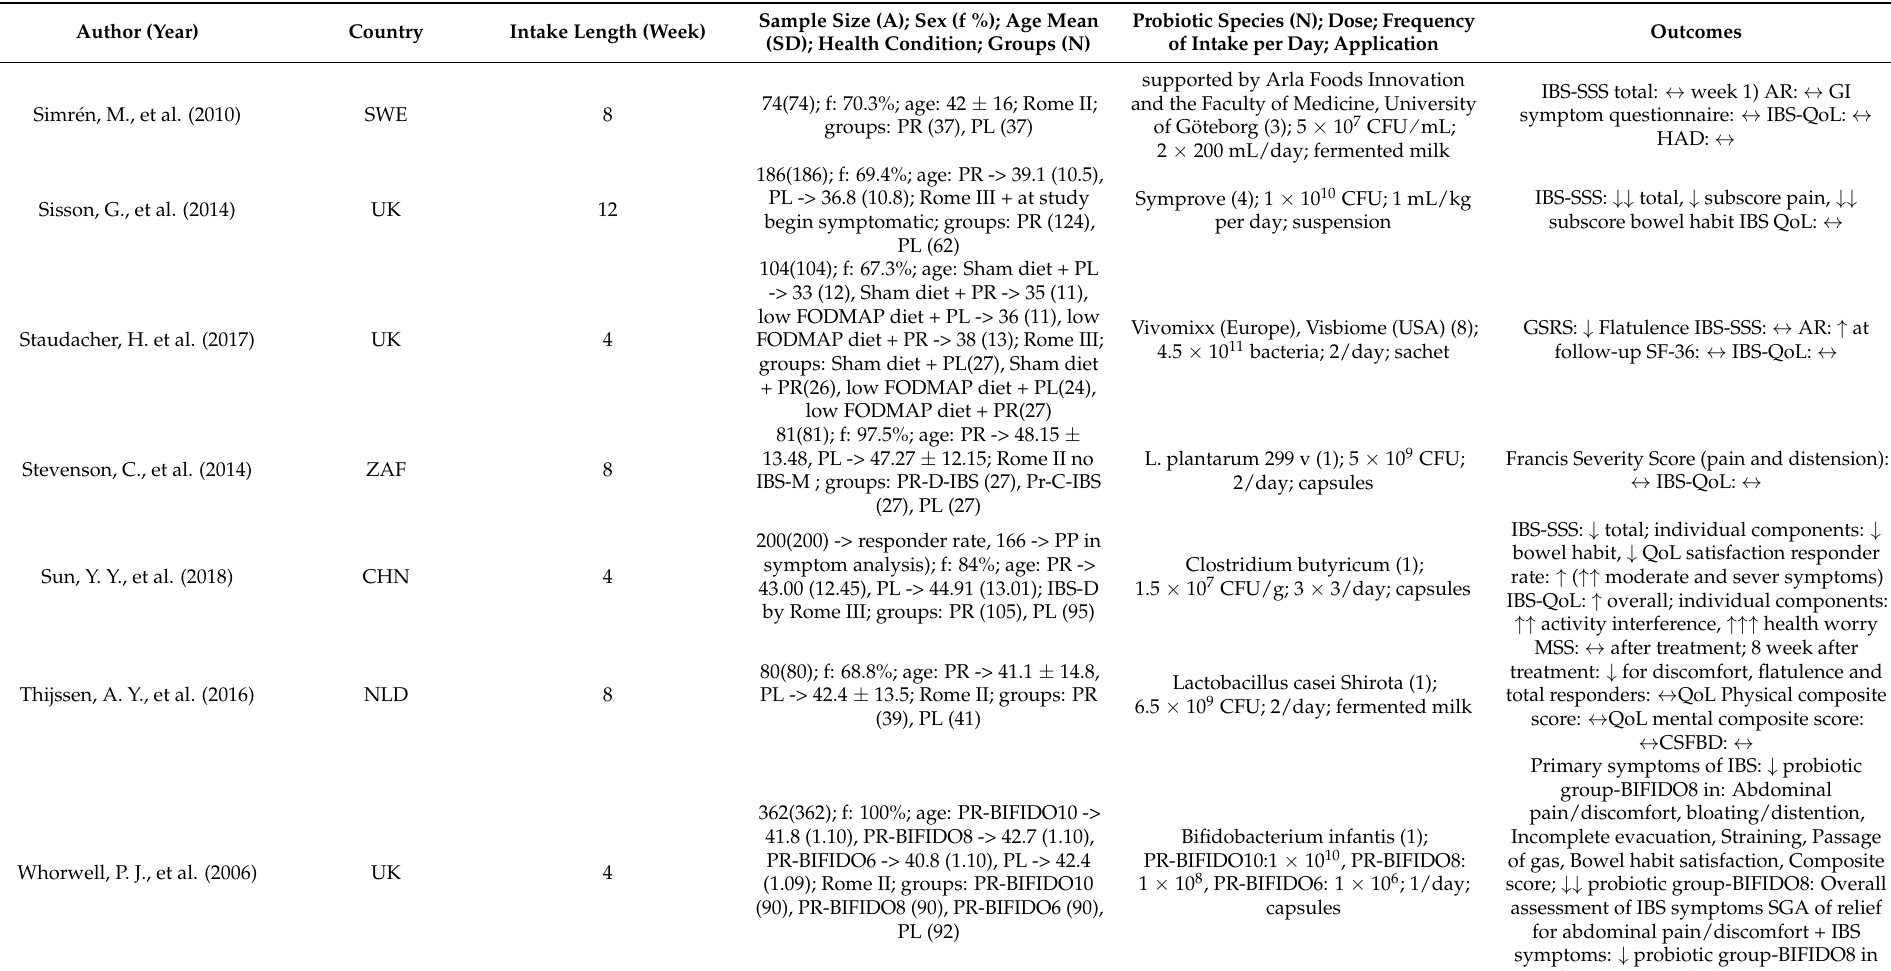
Primary symptoms of IBS: ↓ probiotic group-BIFIDO8 in: Abdominal pain/discomfort, bloating/distention, Incomplete evacuation, Straining, Passage of gas, Bowel habit satisfaction, Composite score; ↓↓ probiotic group-BIFIDO8: Overall assessment of IBS symptoms SGA of relief for abdominal pain/discomfort +